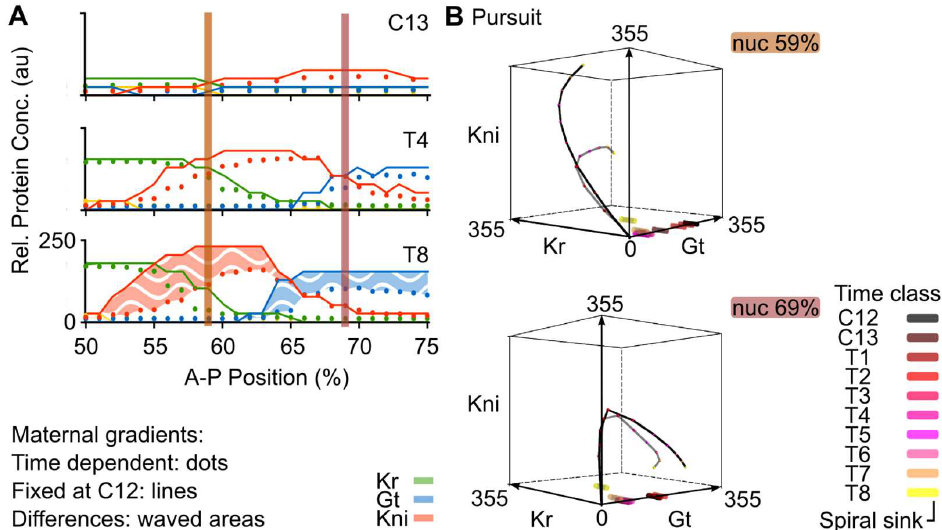
Fig 7. Regulating the extent and timing of posterior gap domain shifts. (A) Output of the non- autonomous genecircuit (dots) versus the same model without maternal gradientdecay (lines) shown at cleavagecycle C13 and C14A (time classes T4 and T8) for nuclei between50–75%A–P position.Axes and colouringscheme as in Fig 3B. Red vertical bars mark the nuclei at 59% and 69%A–P position shown in (B). (B) Phase portraits for nuclei at 59% (top) and 69%A–Pposition (bottom). Phase portraits are shown as three- dimensional projections onto the sub-spacedefinedby Kr (x-axis), Gt (y-axis) and Kni (z-axis) concentrations (in arbitrary units, au). Non-autonomous trajectories shown as grey lines and autonomous trajectories as black lines. Spiral sinks are representedby cylinders.Small coloureddots on trajectoriesindicate the position in phasespace of the trajectory at different time points. Colouring of attractors and trajectory positions indicatestime class (see key). See text for details.